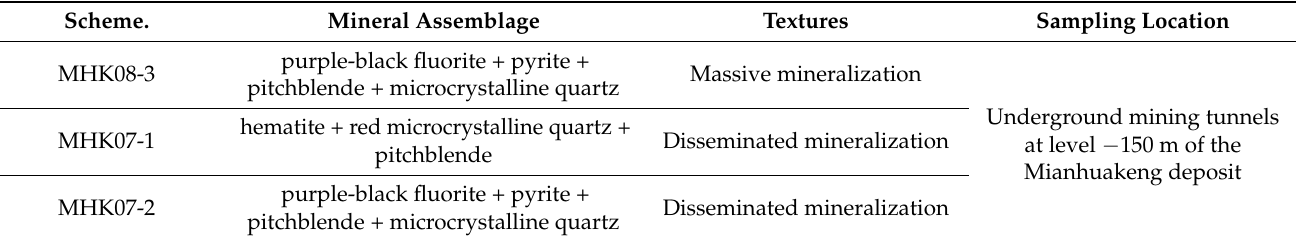
Table 1. The detailed description of mineralization samples collected from the Mianhuakeng uranium